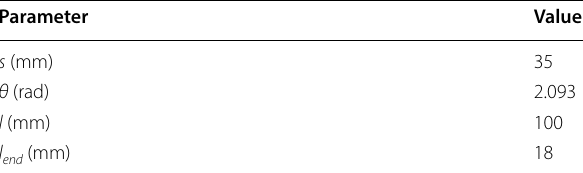
Table 2 Value of intrinsic parameters